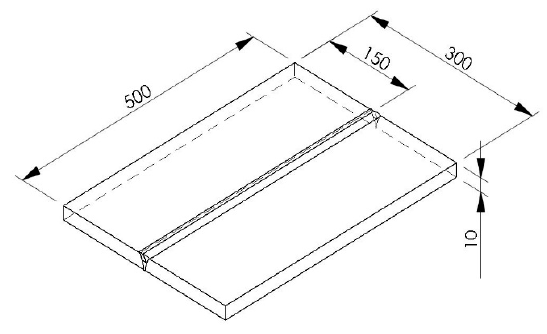
Figure 5. Plate dimensions for butt-joint (mm unit).